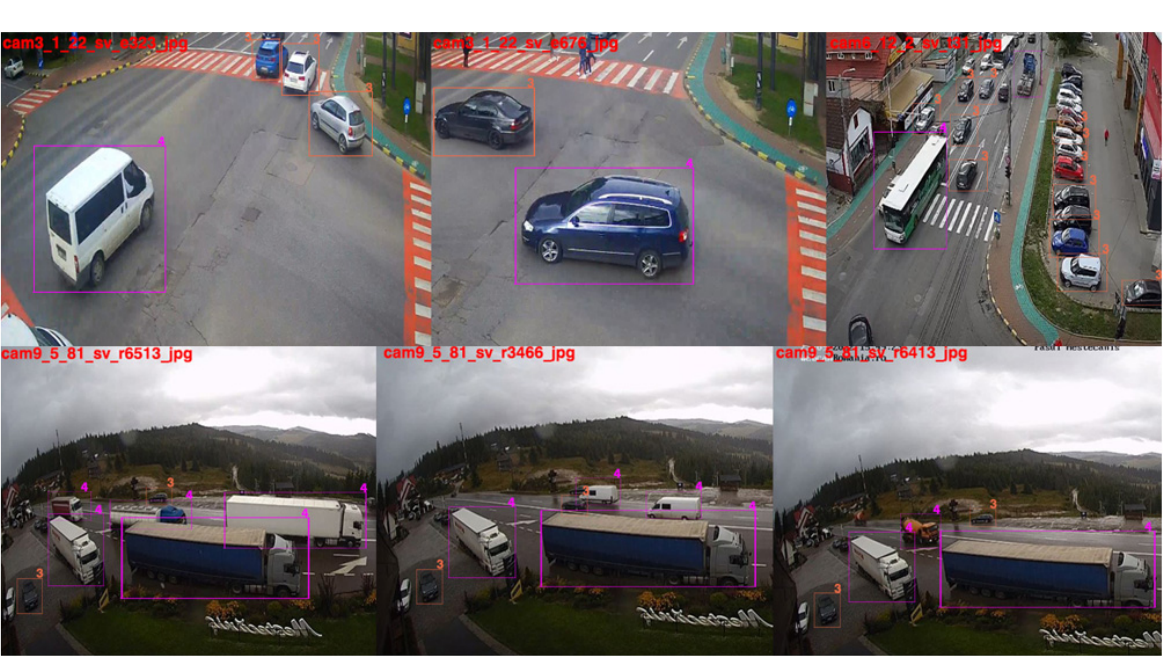
Figure 8. Analysis of the results obtained for the YOLOv5r training model using the SR1 test dataset. Analysis of established classes for vehicles, buses, taxis, bicycles, trucks, vans, auto-trucks.